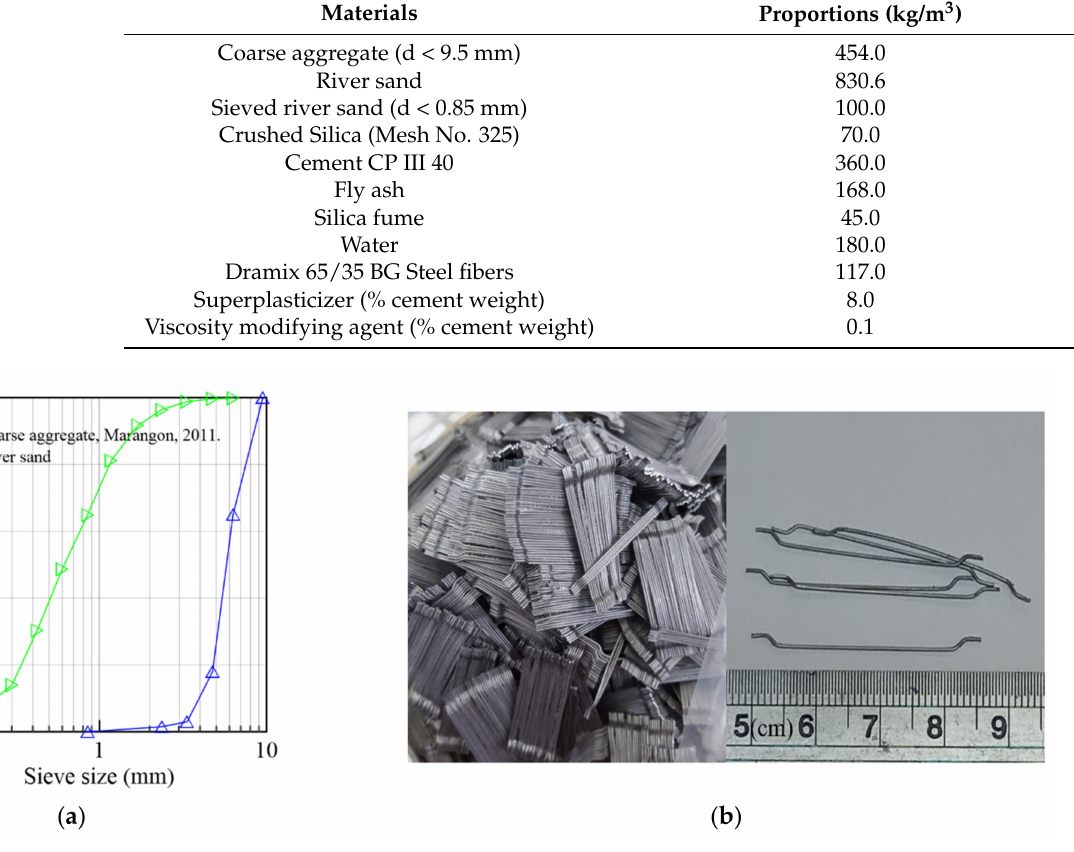
Figure 3. ( a ) Size distribution of aggregates [48] and ( b )